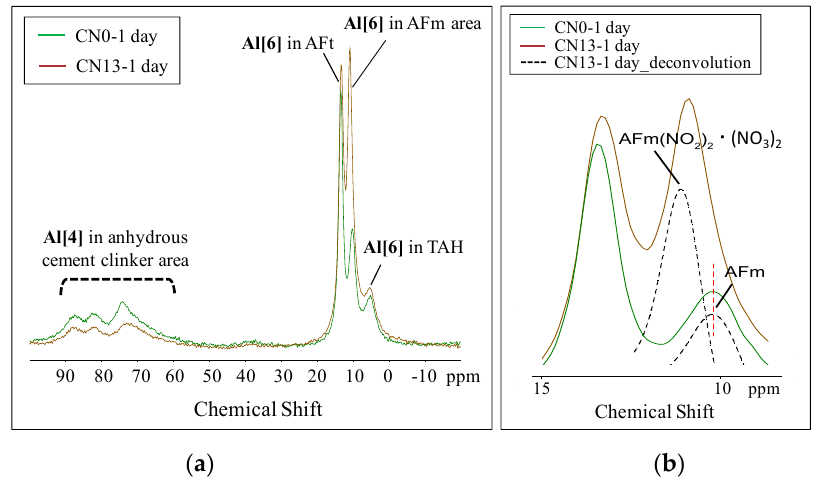
Figure 9. 27 Al NMR spectra of CN0 and CN15 (Day 1). ( a ) Total; ( b ) AFm area.